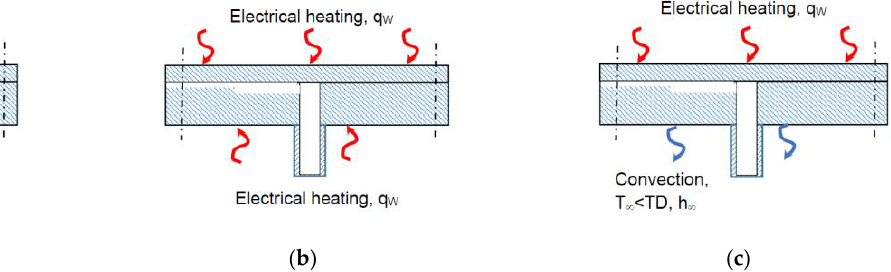
Figure 3. Fundamental modes of operation of a DSHE: ( a ) Convection both sides; ( b ) Conduction both sides; ( c ) Conduction and convection.